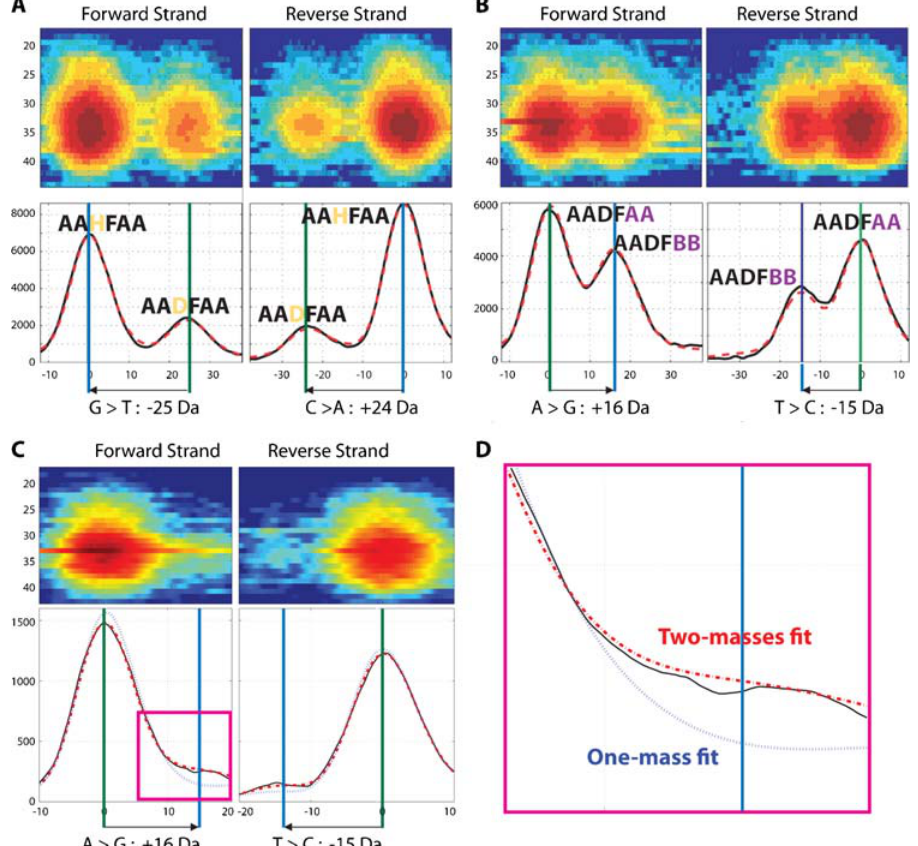
Figure 5. Detection of mixed viral populations. Panels A, B, and C are representations of mass spectral data. The heat maps in the top sections are a charge state representation of the data; the spectral plots in the lower sections were created by filtering the charge state responses to create signal representations vs. mass. The main peaks on the spectral plots are the primary amplicons and appear as hot spots in the charge state representations; the secondary amplicons appear as ‘‘cloudy’’ regions to the right and left for the forward and reverse strands, respectively. Panels A and B contain two species in relatively large ratios (20–50% mixtures) and involve the season 2005–2006 parent BC-type (AADFAA) and a type with a single mutation (panel A, within the M1 amplicon, BC-type AA H FAA; panel B, within the overlapping NS1 and NS2 amplicons, BC-type AADF BB ). Panel C shows detection of a low abundance type (2–5%). Panel D shows a close-up view of the mass spectrum from Panel C. In this view, the shoulder of the peak is fit with a single mass model (blue dotted line) and a two mass model (dashed red